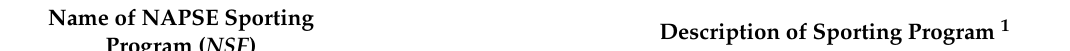
Table 1. Description of the NAPSE sporting programs included in the